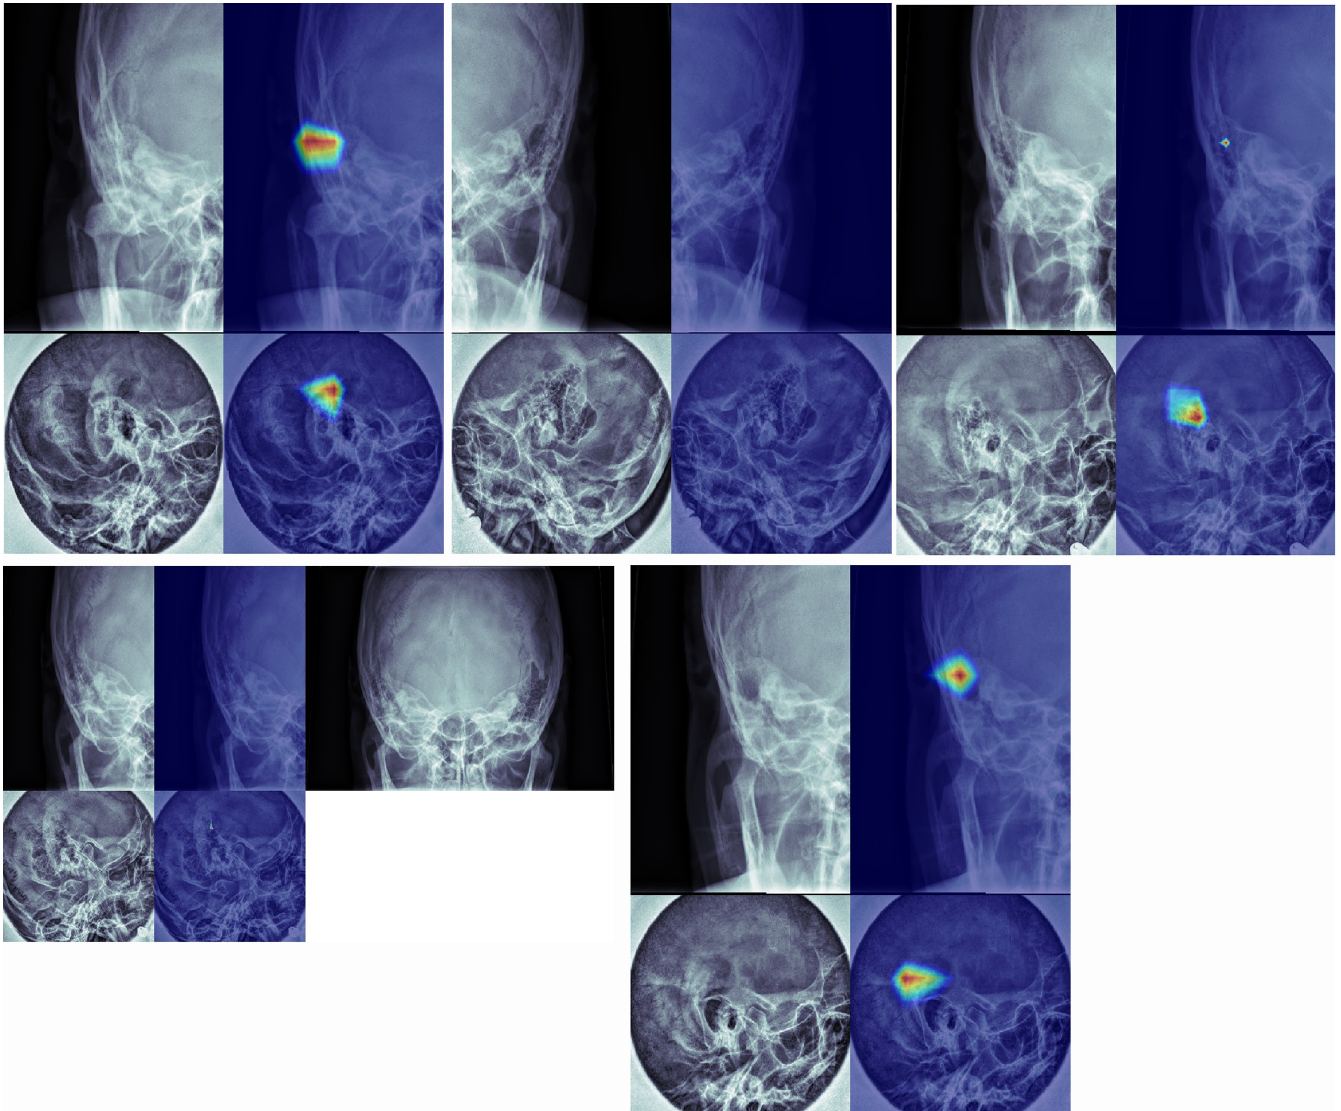
Fig 7. Class activation mappings of true positive (a), true negative (b), false positive (c), false negative (d), and postoperative state (e) examples . (a) Lesion related regions in mastoid air cells are detected on both AP view and lateral view. (b) No specific region is detected in either AP view or lateral view. (c) A false lesion related region is detected on lateral view. (d) Equivocal haziness is suspected on both views. The algorithm diagnosed this case as normal. An AP view with bilateral sides (right upper) shows marked asymmetry suggesting abnormality in right side. (e) Both views show lesion related regions.